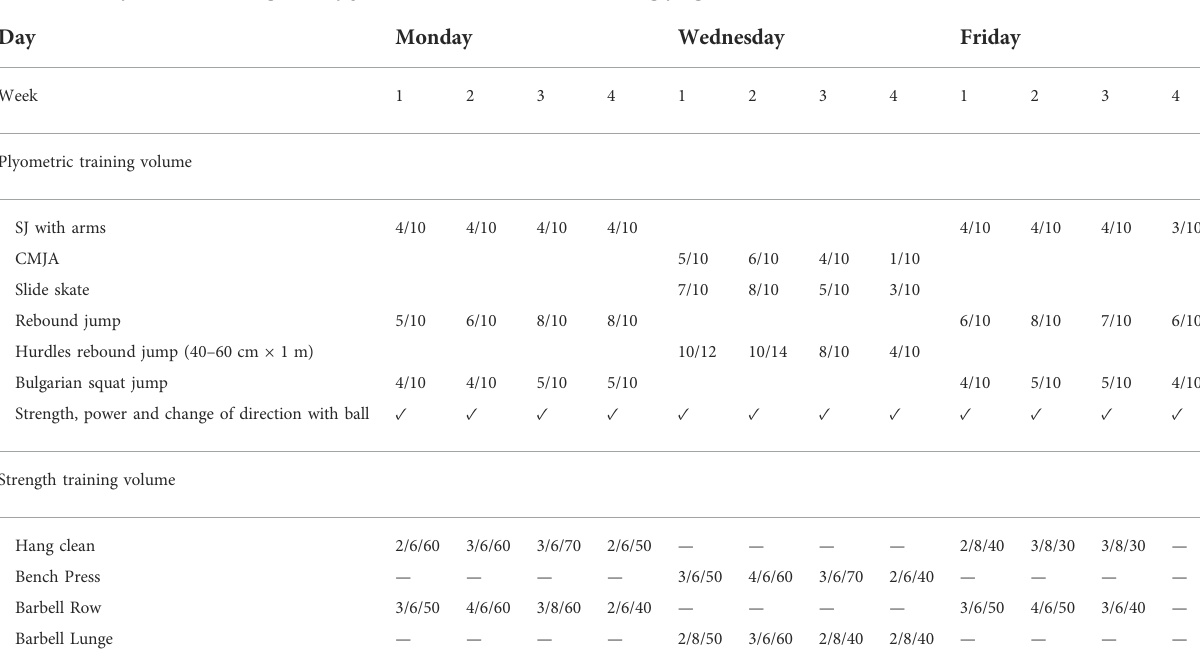
TABLE 1 Description of the strength and plyometric volume distribution training